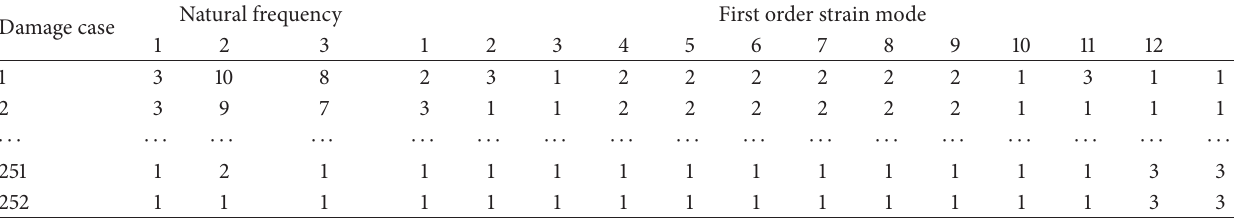
Table 10: Attribute set 1 rules generation for damage position.